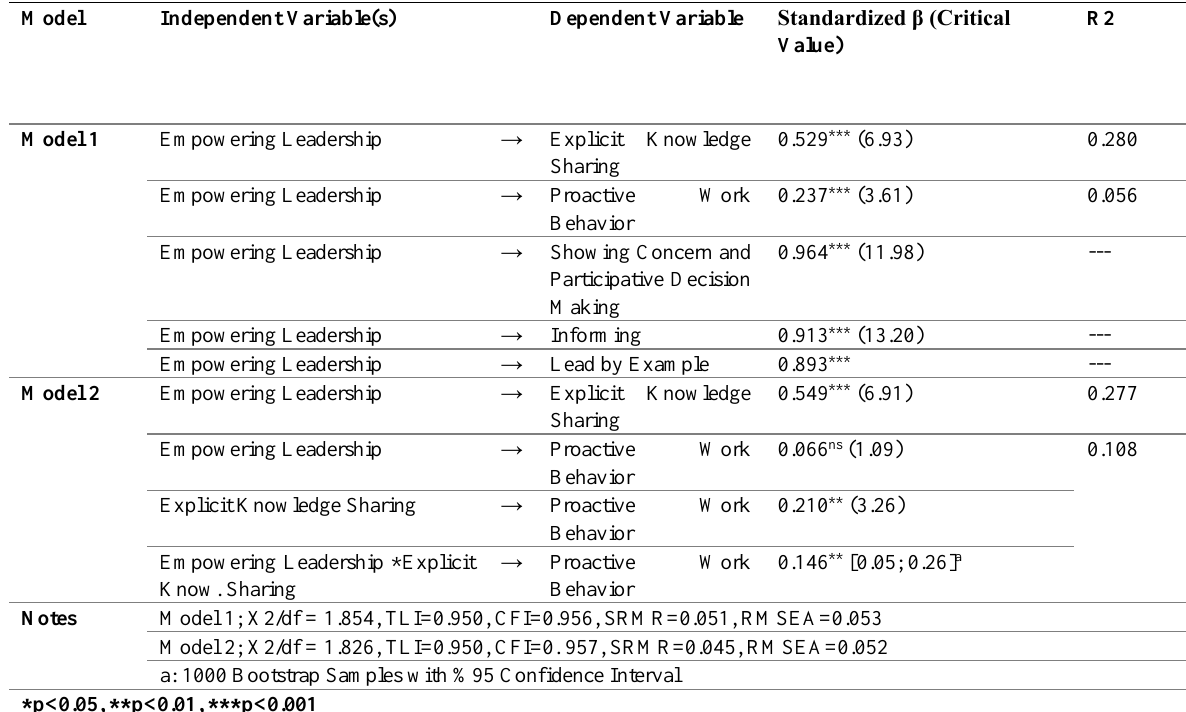
Table 3: Structural Equation Model